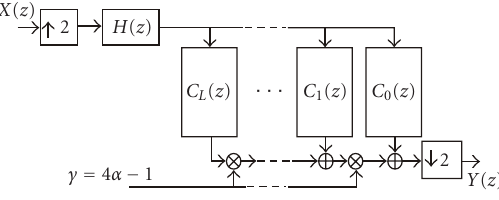
Figure 4: Initial structure of the proposed